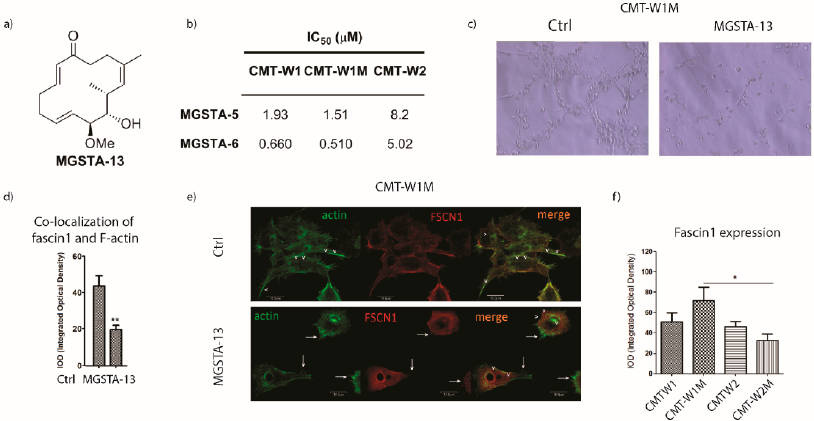
Figure 8. ( a ) Structure of MGSTA-13 ; ( b ) Chamber cell migration assay with canine mammary cancer cell lines; ( c ) Growth characteristics of CMT-W1, cell lines cultured on Matrigel and treated with MGSTA-13 100 µM for 24 h; ( d ) Quantification of fascin1 and F-actin co-localization at merge